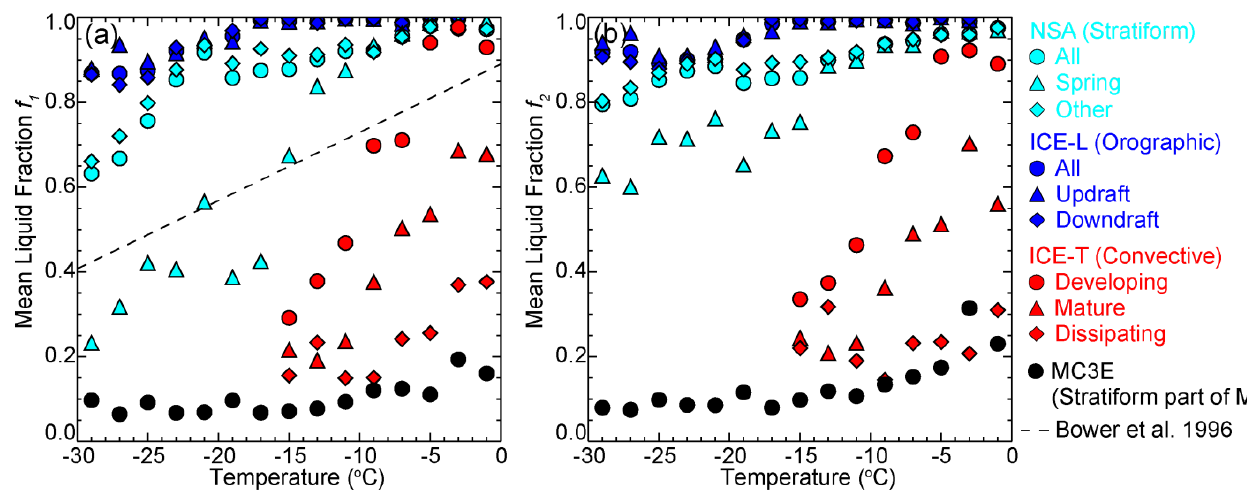
Figure 4. ( a ) Mean liquid fractions as a function of temperature for stratiform clouds sampled at the NSA site, orographic clouds sampled in ICE-L, tropical maritime convective clouds sampled in ICE-T, and stratiform parts of MCSs sampled in MC3E, as well as a parameterization from a previous study. The mean liquid fractions were calculated using Equation (1) for every 2 °C. ( b ) Similar to ( a ), but the mean liquid fractions were calculated using Equation (2).